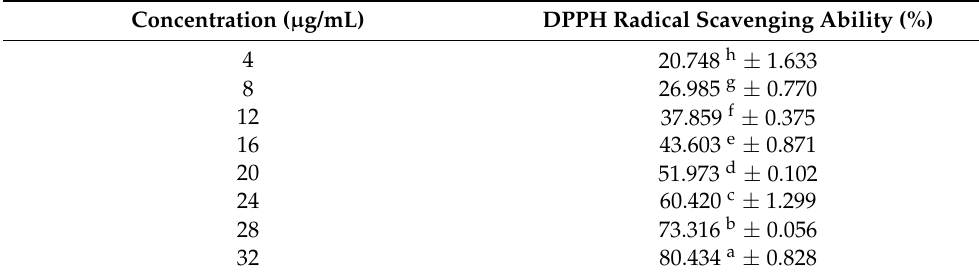
Table 8. DPPH free radicals scavenging activity of ascorbic